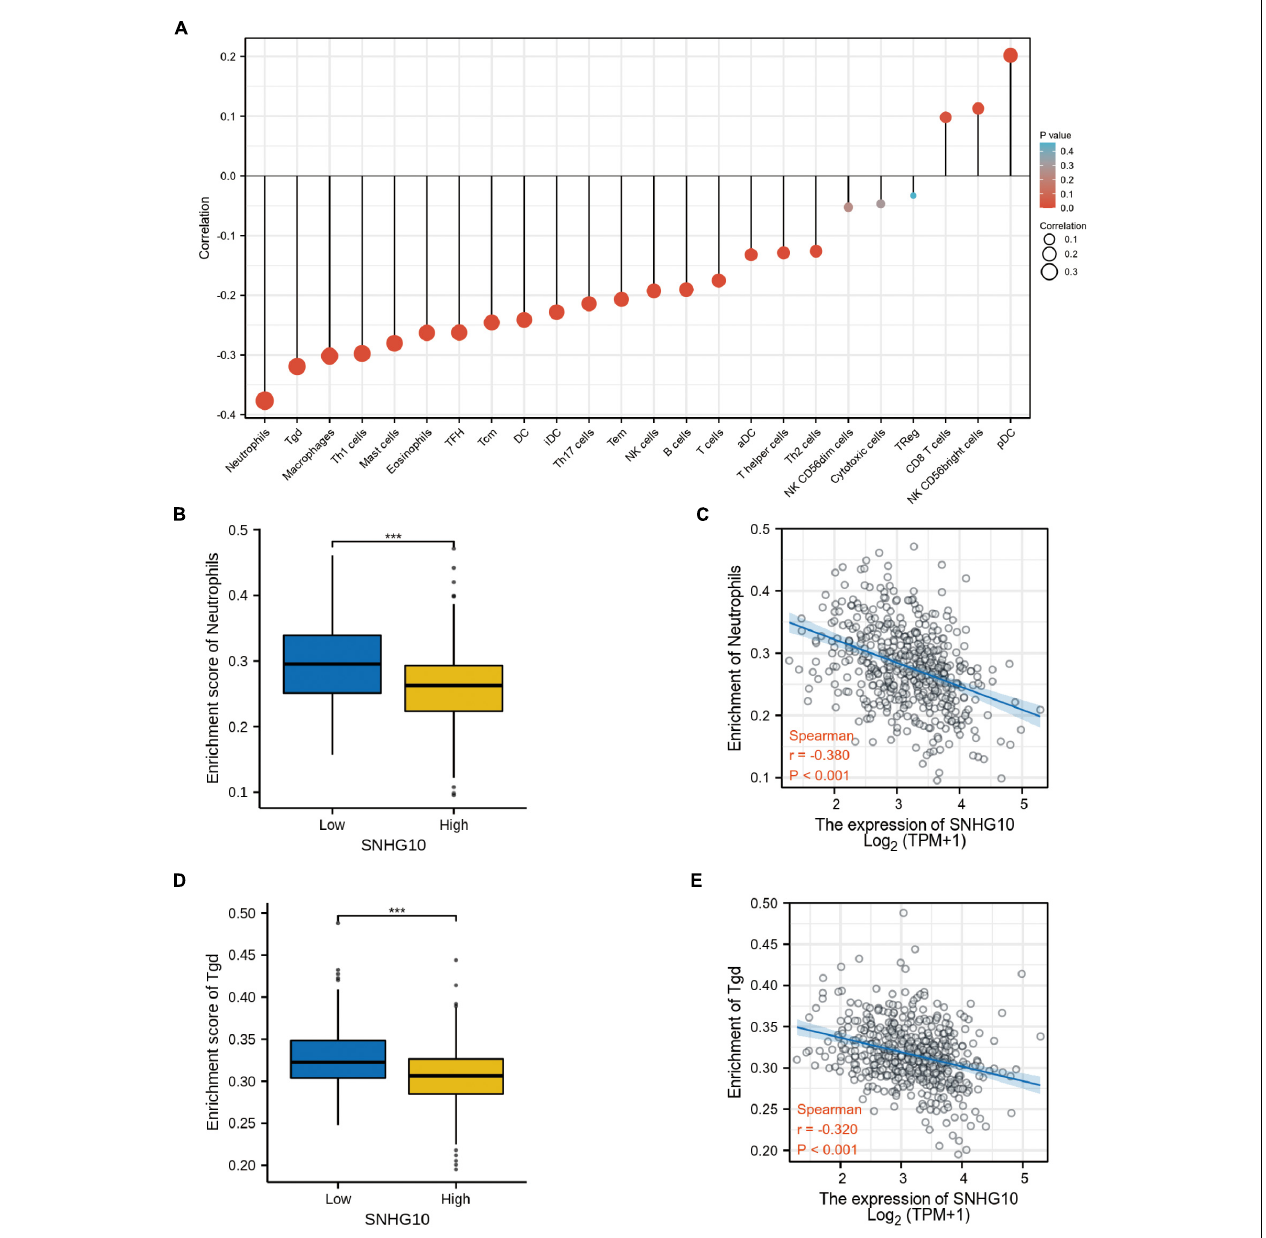
FIGURE 6 | SNHG10 expression associates with immune infiltration in the tumor microenvironment. (A) The forest plot shows the correlation between SNHG10 expression and 24 immune cell types. (B) Differences in neutrophils cell infiltration between SNHG10 low and high expression groups. (C) The correlation between SNHG10 expression and proportion of neutrophils. (D) Differences in T γδ infiltration between SNHG10 low and high expression groups. (E) Correlation between SNHG10 expression and T γδ . T γδ , T gamma delta. *** P <